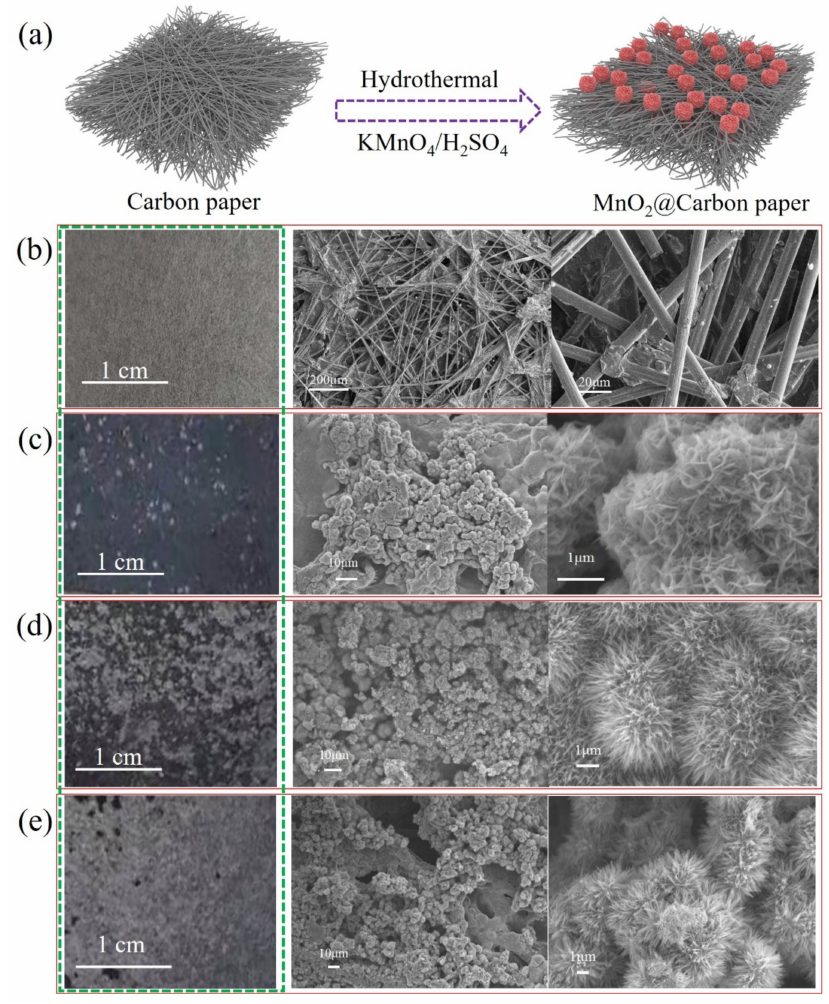
Figure 2. Schematic illustration of the fabrication of carbon paper/MnO 2 ( a ), optical (in the green outline), and SEM images of CP ( b ), MC-1 ( c ), MC-3 ( d ), and MC-5 ( e